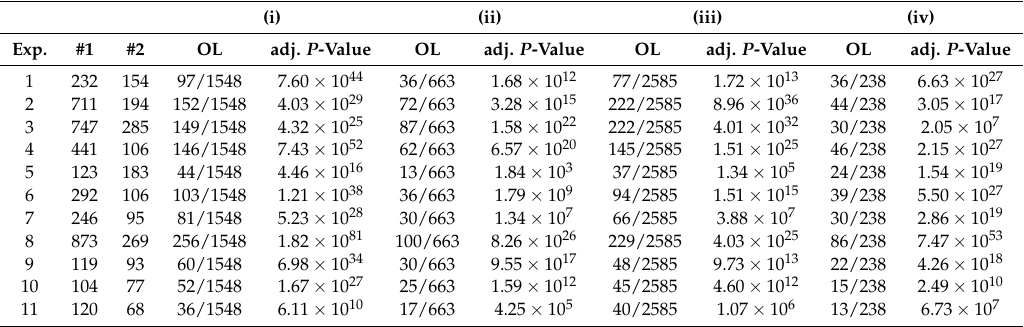
Table 11. In each of the 11 experiments, 20 top-ranked significant terms in GeneSigDB whose set of associated genes significantly overlapped with the set of genes selected for each experiment were identified.